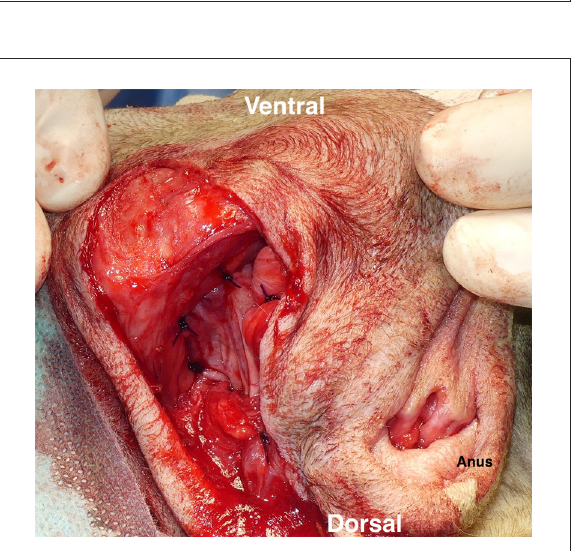
FIGURE6 Coverage of a right-sided perineal hernia with the expanded tunica vaginalis communis (TVC). The TVC was sutured with the external anal sphincter muscle on the medial side, the sacrotuberous ligament on the lateral side, and the internal obturator muscle and the ischial periosteum on the ventral side.